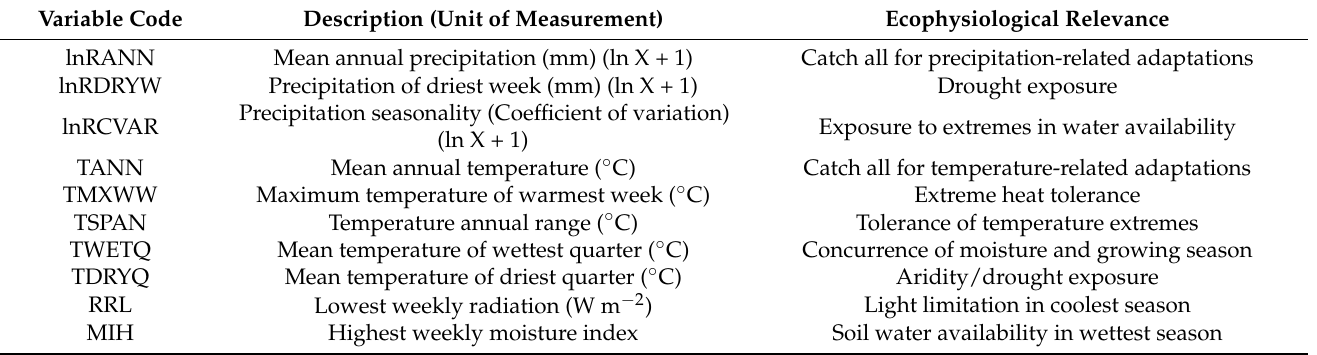
Table 7. Climate variables included in the analysis (See Table S5 for sources and